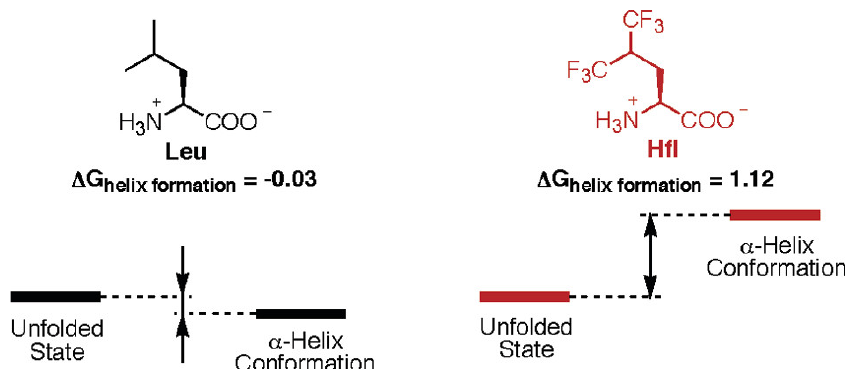
Figure 5. Structures and helical propensities of Leu and Hfl. Reprinted with permission from [32]. Copyright 2006 American Chemical Society.